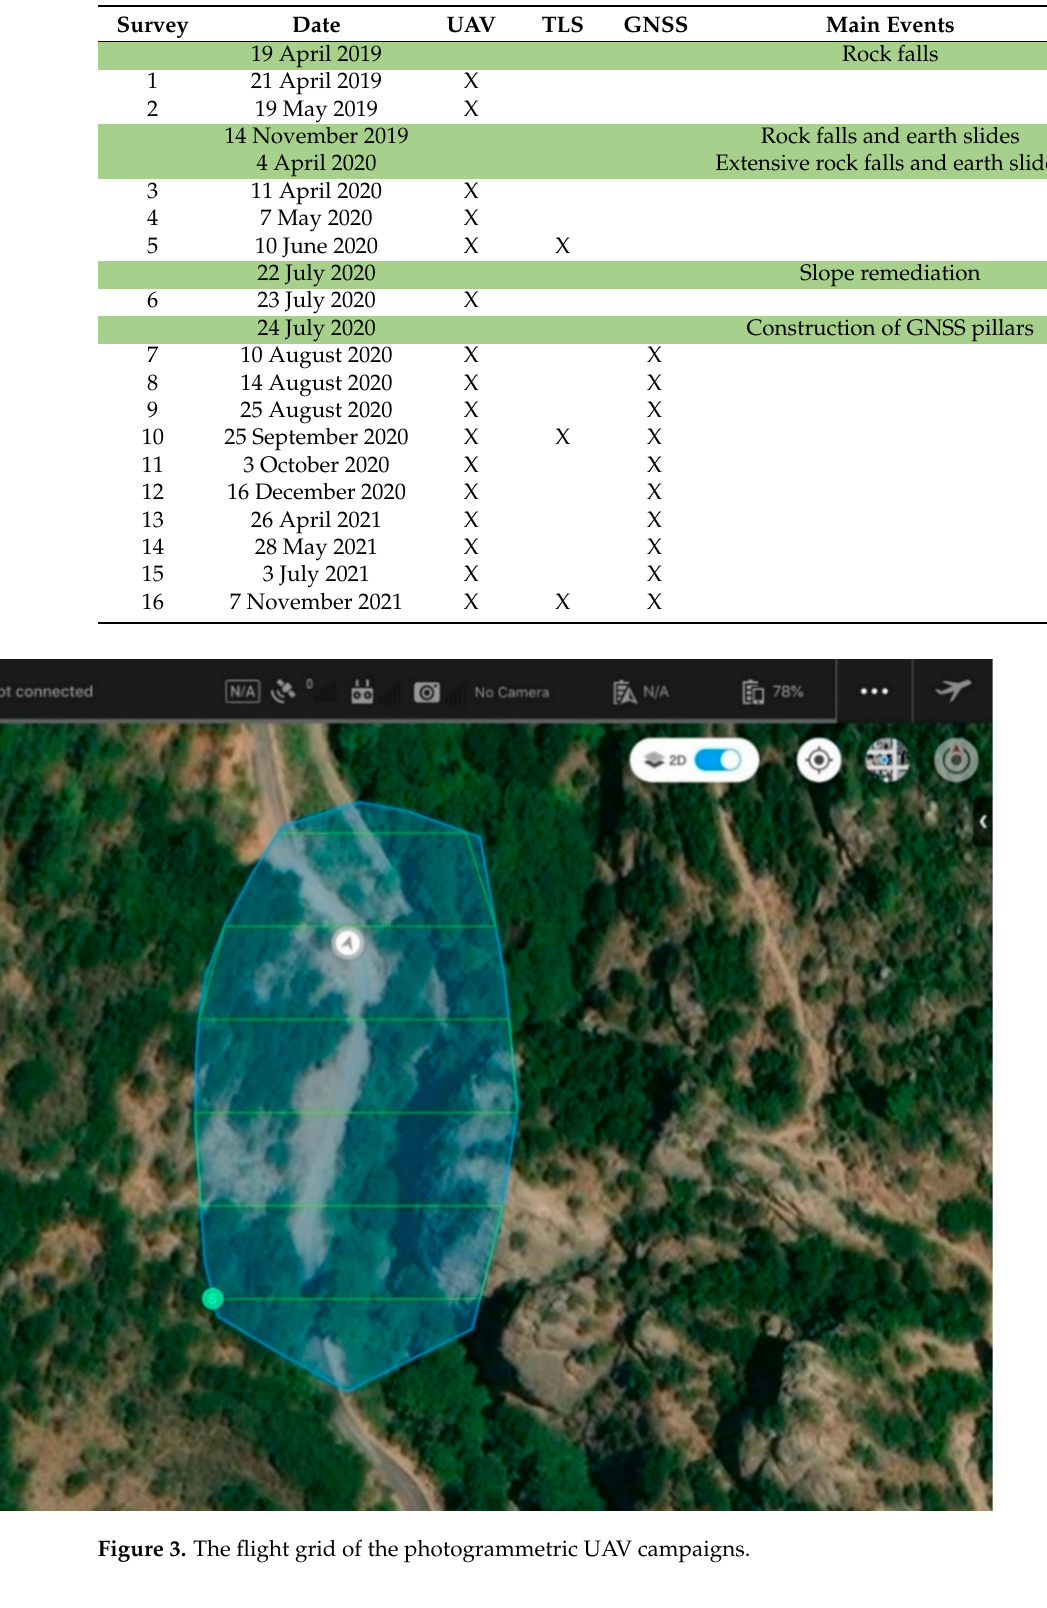
Table 1. Dates of the repeated UAV, TLS and GNSS surveys.